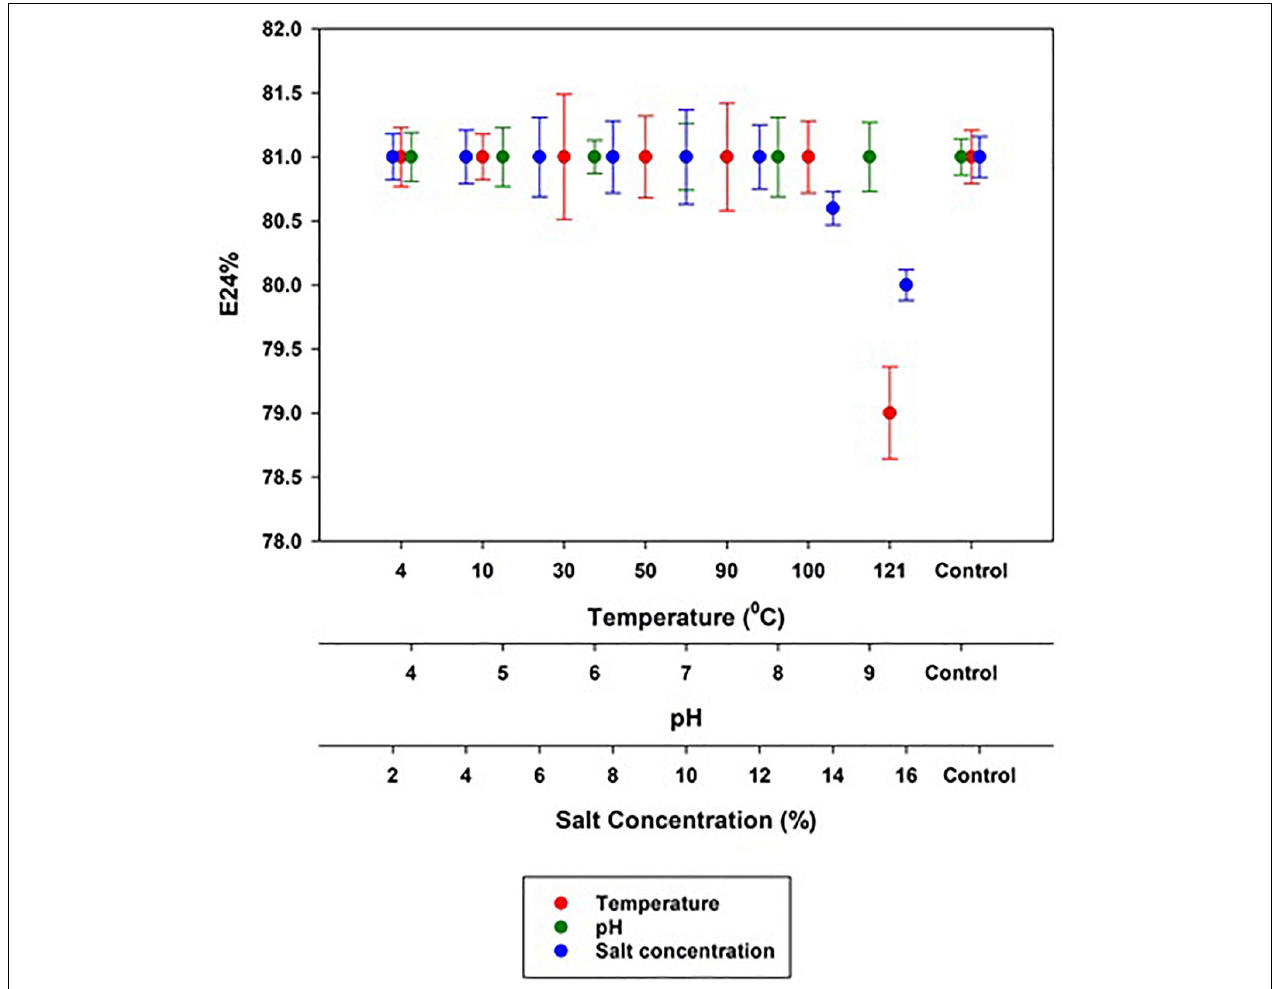
FIGURE 6 | Stability of the MSI 54 lipopeptide at varying temperature, pH, and salt